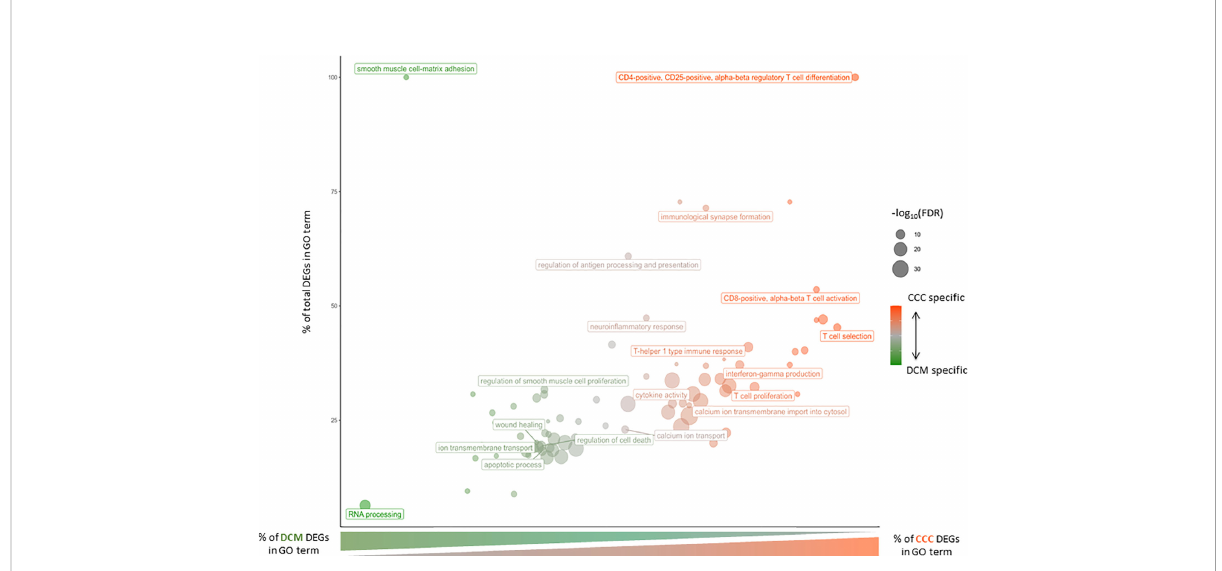
FIGURE 3 Gene Ontology Biological Process affected in severe CCC and/or DCM. Bubble chart of Gene Ontology Biological Process according to percent of severe CCC differentially expressed genes (DEG) and percent of total DEG (severe CCC + DCM) involved in each GO term. The size of each dot is associated to the enrichment of each GO term [-log 10 (FDR)] and its color to disease speci fi city (from green for DCM to red for severe